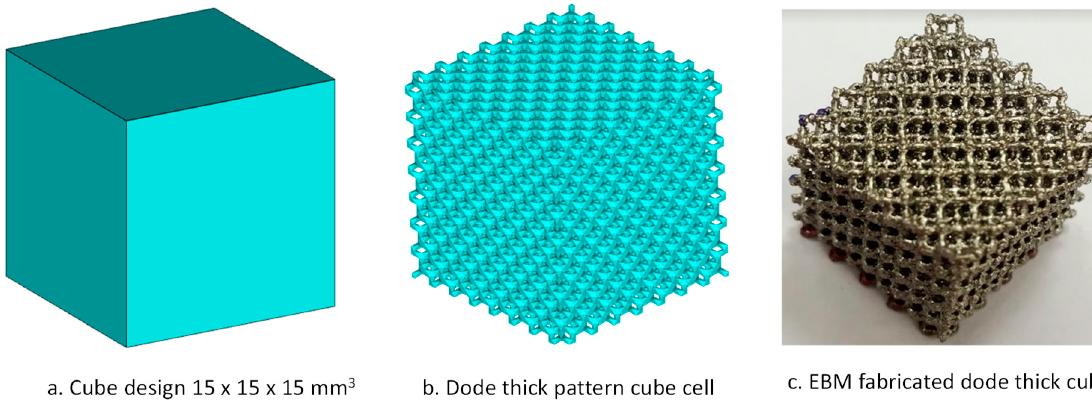
Figure 6. Transformation and fabrication of dode thick cube structure.